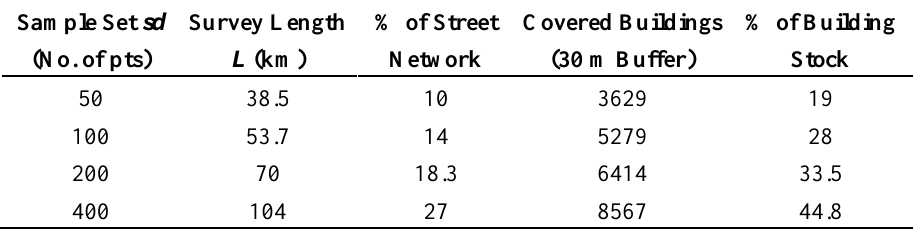
Figure 15. Comparison between the length of the resulting route in the optimized case (blue plot) and in the random case (black plot with red points) ( top) . As the plot shows, the route length is proportional to the square root of the dimension of the sample set, and the random route is systematically longer. Comparison of the expected number of covered policies with respect to route length (in km) for random sampling (black line, red dots) and focused sampling (blue line, blue dots) (bottom) . The relationship is apparently linear for the focused sampling, while it appears to not be linear for the random sampling, which is much less efficient in any case. Table 6. Empirical correlation between dimension of the sample sets, length of the resulting survey (in km), and number of covered buildings ( i.e. , lying within a 30-m buffer from the driven